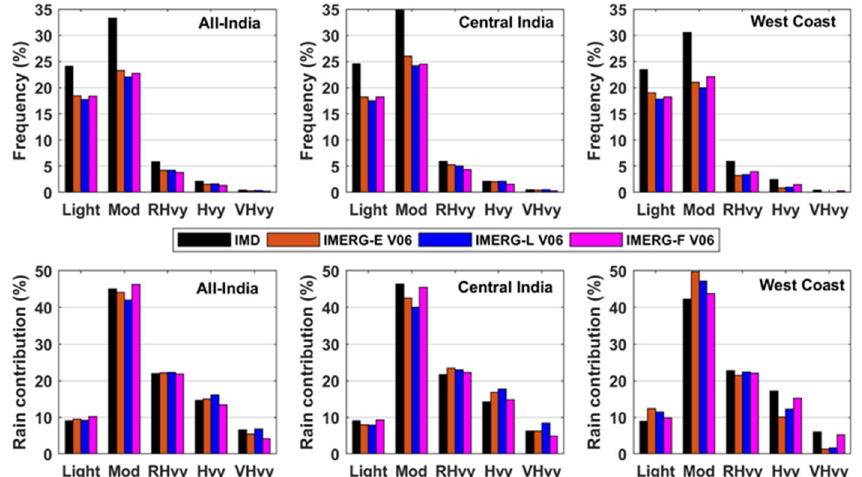
Figure 11. Frequency and contribution of different rainfall intensity intervals to the total monsoon rainfall for all-India, central India, and west coast from the IMD rain-gauge-based data and IMERG version 6 estimates for 2014–2017.